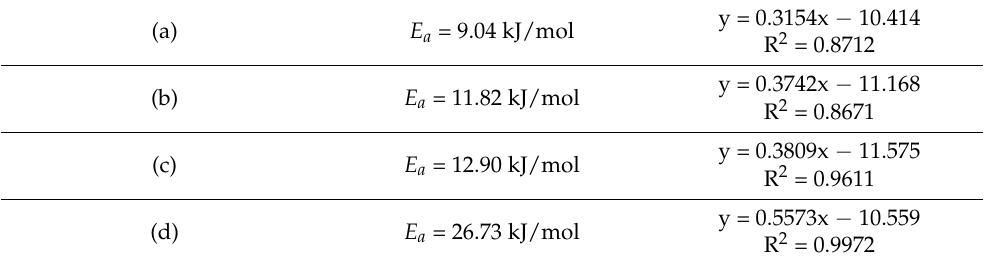
Table 4. Apparent activation energy and reliability parameters of the linear approximation.